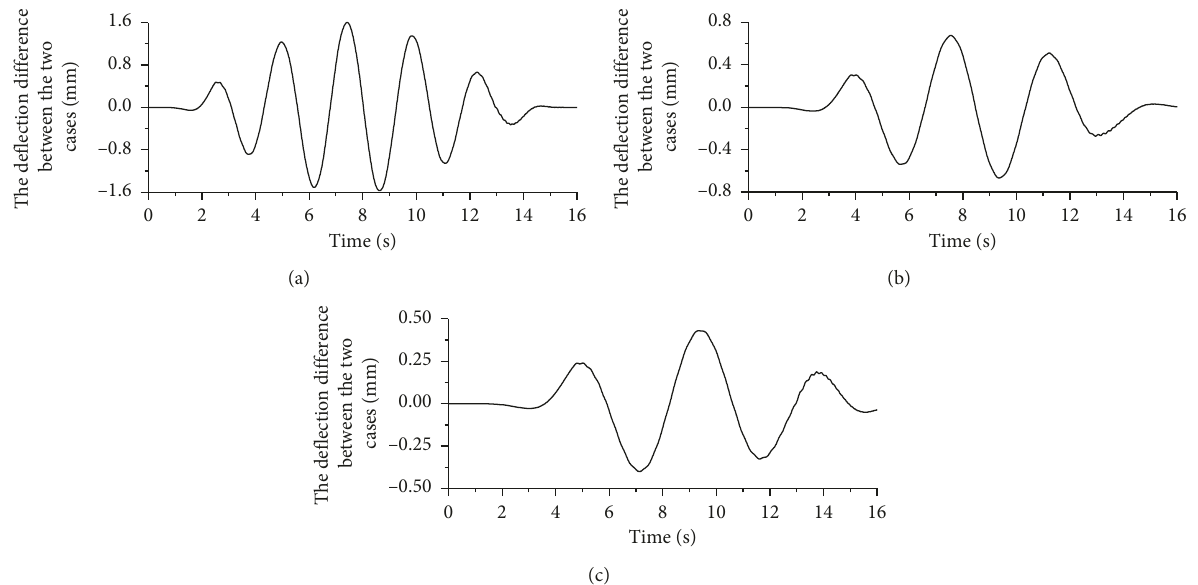
Figure 11: The difference between the two models: (a) when the cable length is 6m; (b) when the cable length is 14m; (c) when the cable length is 22m.